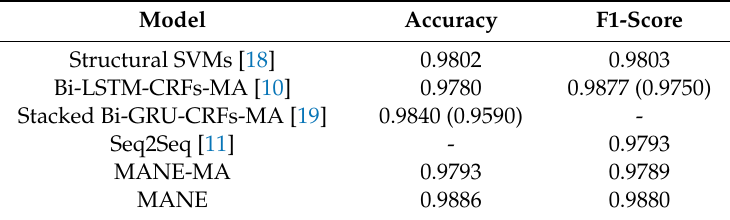
Table 5. Performance comparison on morphological analysis.